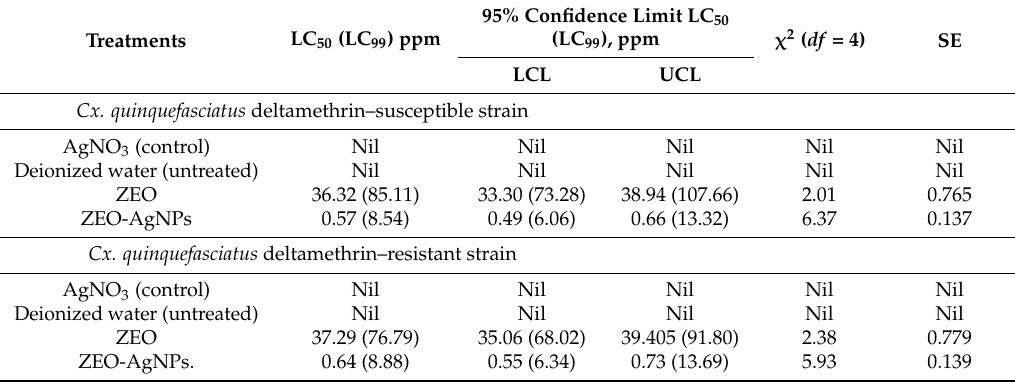
Table 1. Larvicidal activity of C. zedoaria essential oil (ZEO) and AgNPs synthesized using C. zedoaria oil (ZEO-AgNPs) against deltamethrin-susceptible and -resistant strains of Cx. quinquefasciatus